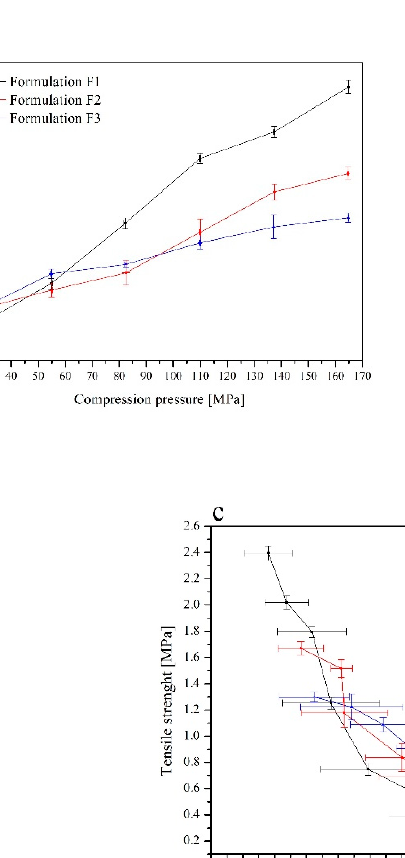
Figure 4. Tabletability ( A ), compressibility ( B ), and compactibility ( C ) profiles of the formulations F1– F3.